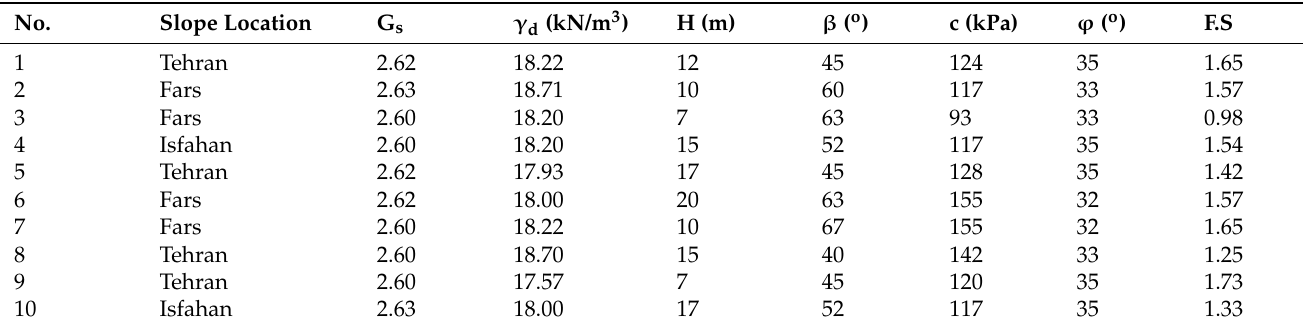
Table 4. Studied slopes’ geometrical